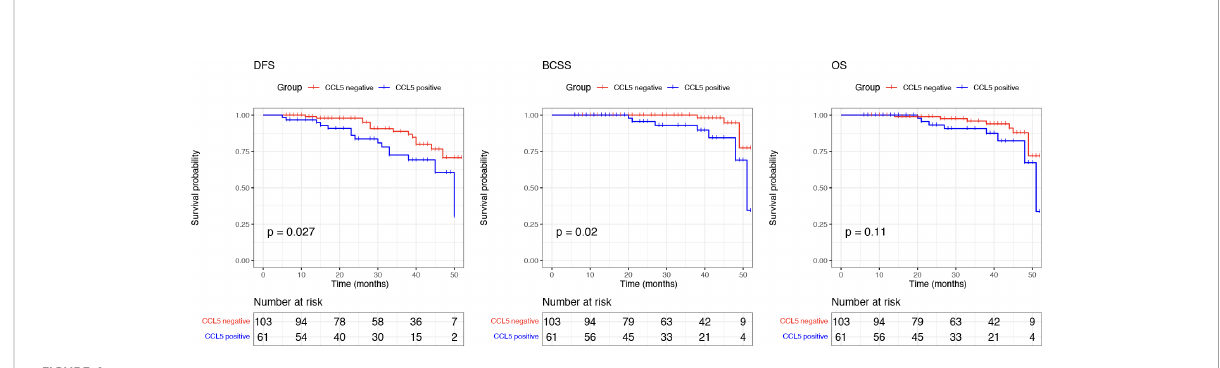
FIGURE 4 Breast cancer patients negative for CCL5 have better DFS and BCSS.